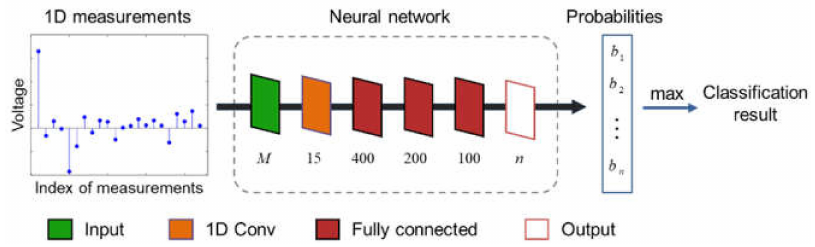
Figure 5. Framework of the neural network.